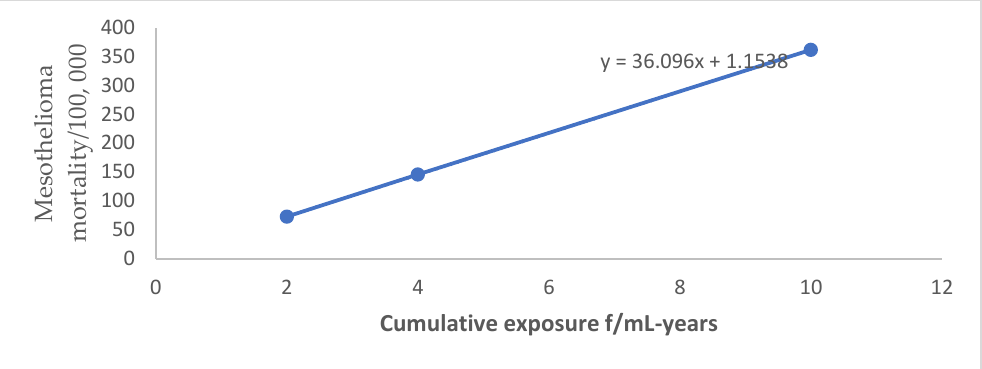
Figure 2. Mesothelioma mortality by cumulative exposure linear regression equation.